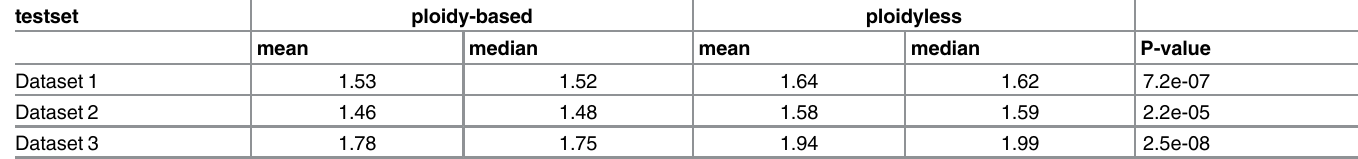
Table 4. Average edge weights (entropy) of the generated trees. P-values were generated using a two-sided paired Wilcoxon test.